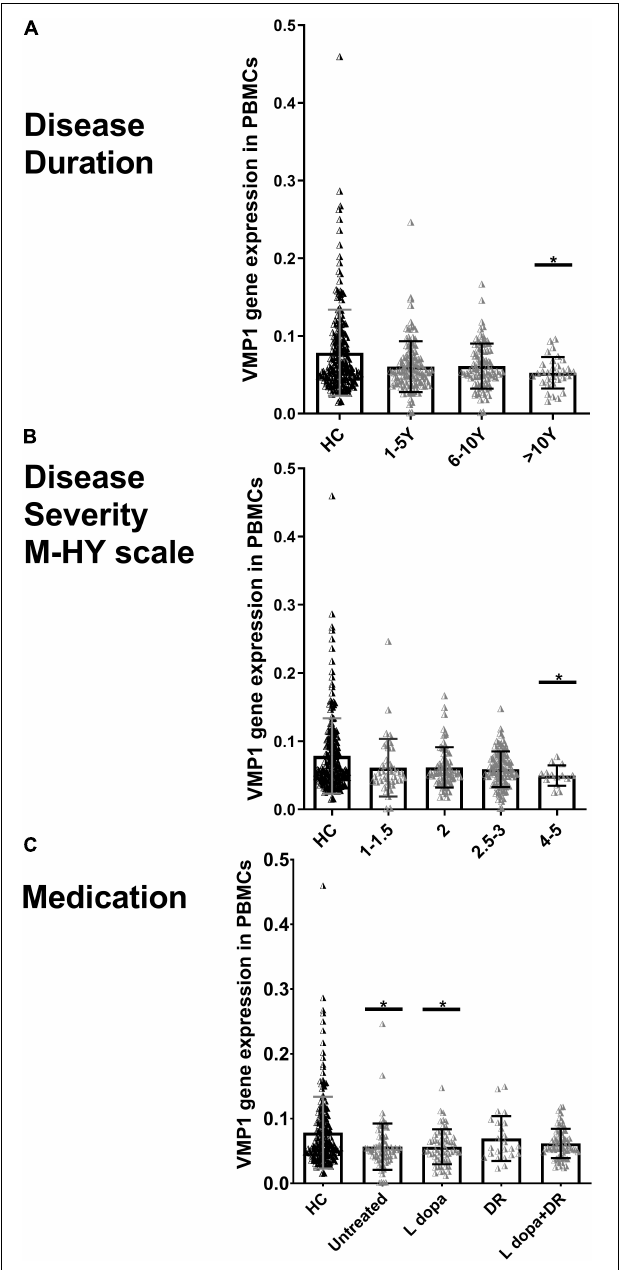
FIGURE 3 | Real-time quantitative PCR analysis for the VMP1 expression levels in PBMCs and clinical characteristics of PD patients. (A) Disease duration, (B) disease severity M-HY, Modified Hoehn and Yahr scale, and (C) medications. DR, DA receptor agonists monotherapy; L-dopa, L-dopa monotherapy; L-dopa + DR, the combination of DA agonists and L-dopa. Horizontal bars represent mean and SE values. * p < 0.05 significantly lower than that of